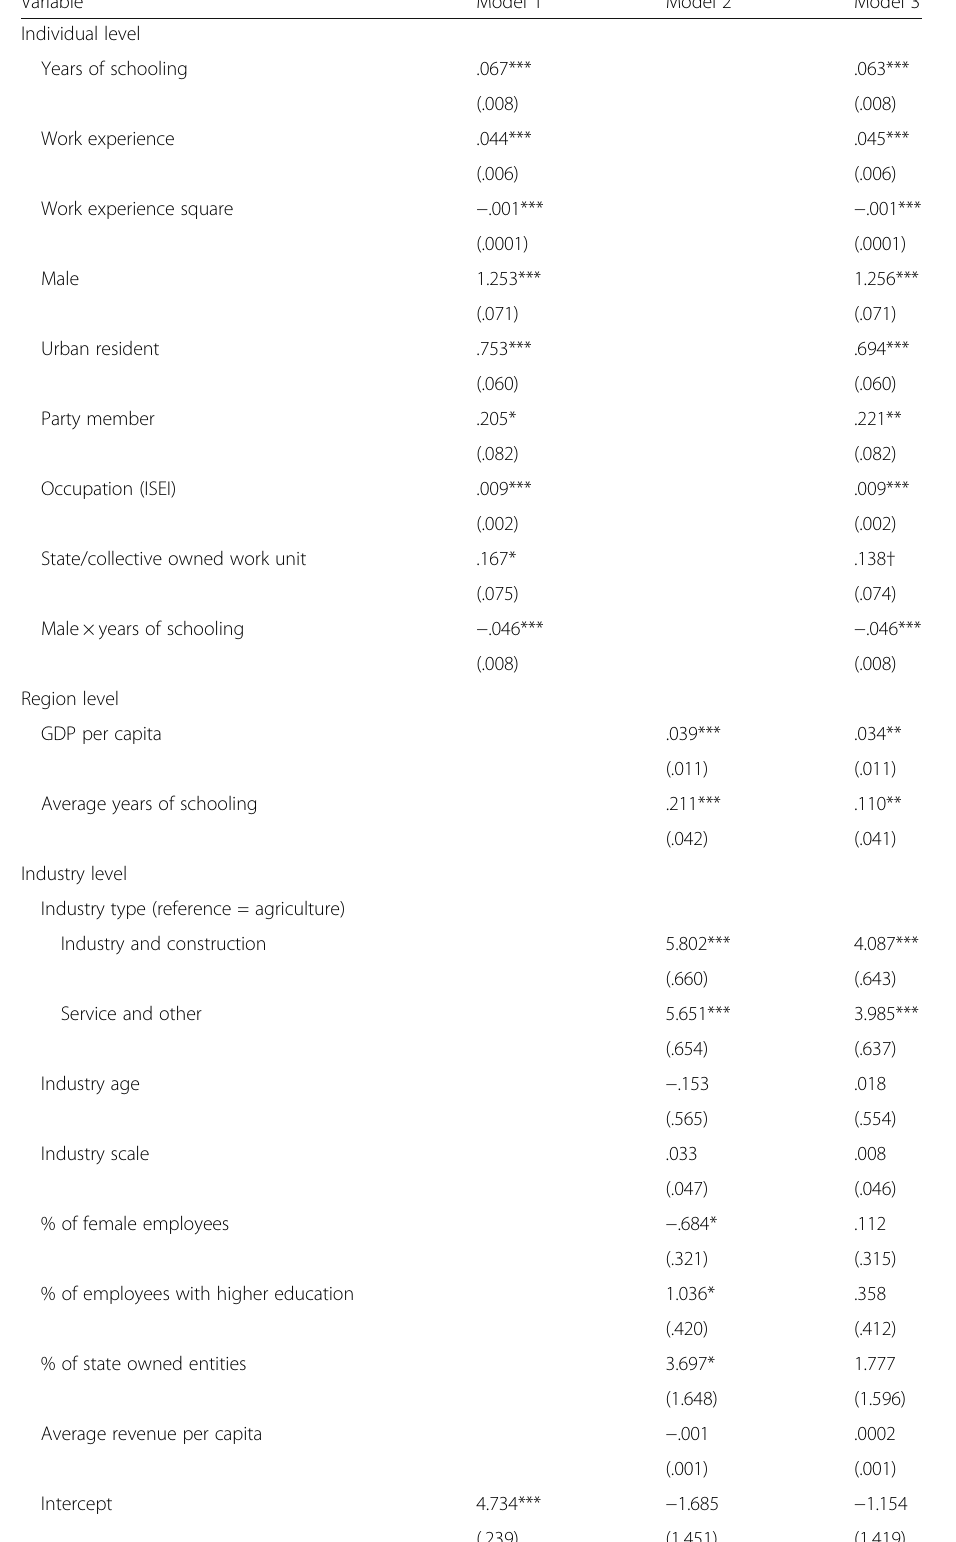
Table 3 Cross-classified multilevel models for individual monthly income (Log),